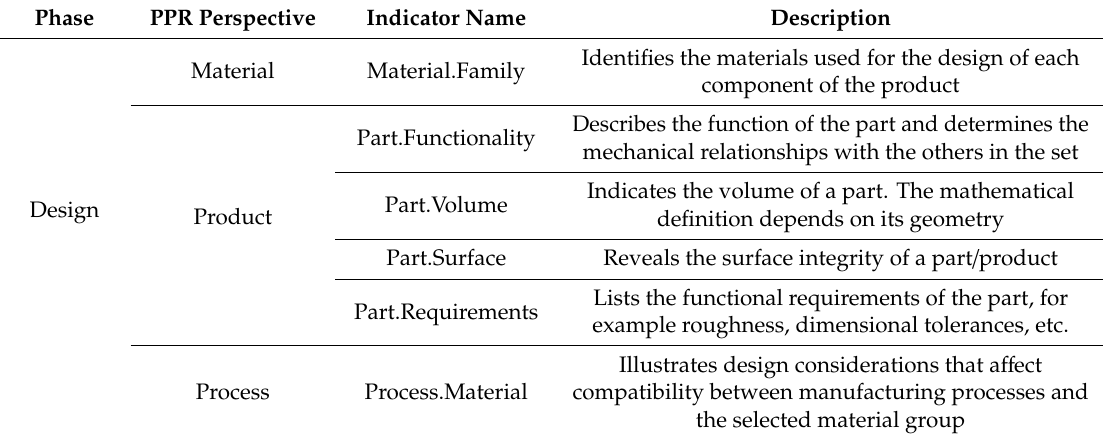
Table 4. Design phase indicators